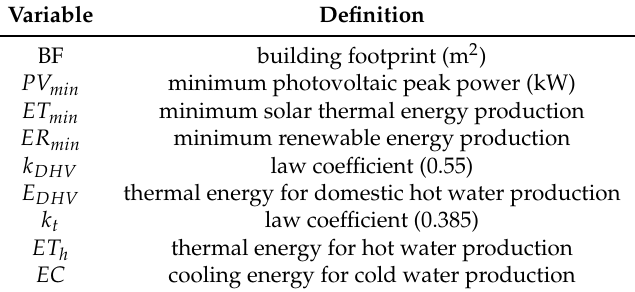
Table 1. List of variables mentioned in Section